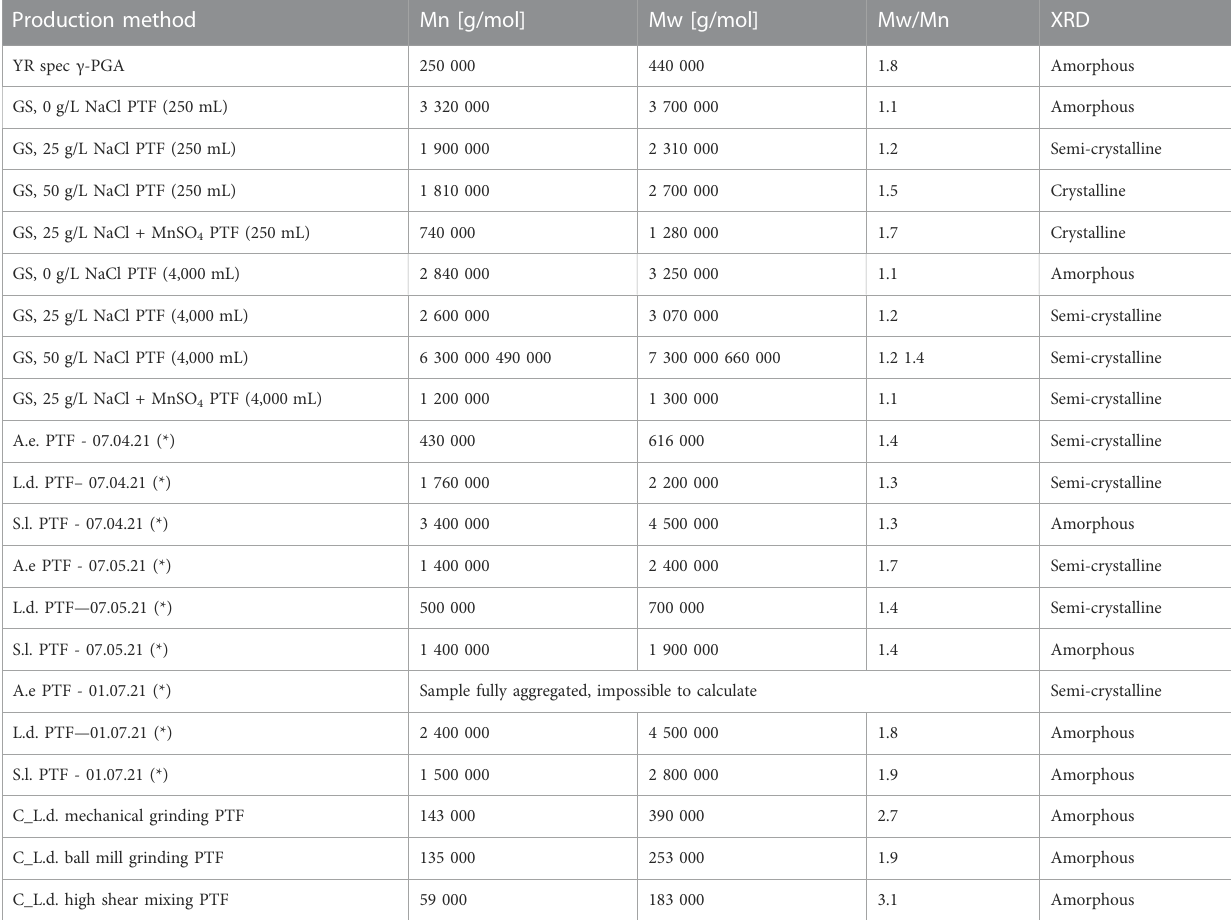
TABLE2Physicalcharacteristicsofcommercial γ -PGAand γ -PGAsynthesisedfromGS/algalmedia.Samplesmarkedwith*indicatehighlyaggregatedmaterial;for which calculation was carried out only for the range where there was good